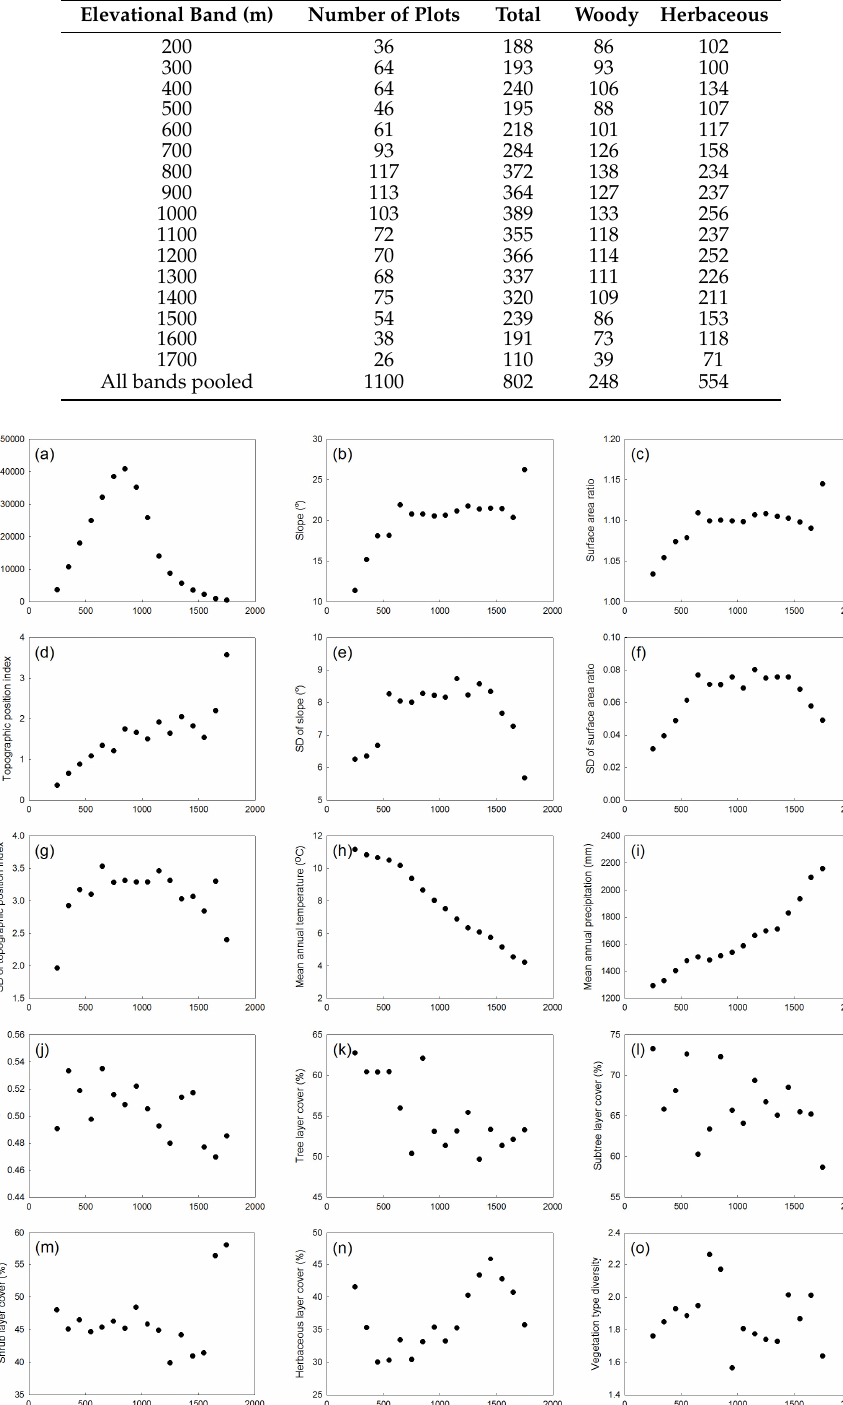
Table 1. Observed species richness among total, woody and herbaceous plants for different elevational bands along the ridge of the Baekdudaegan Mountains, South Korea.